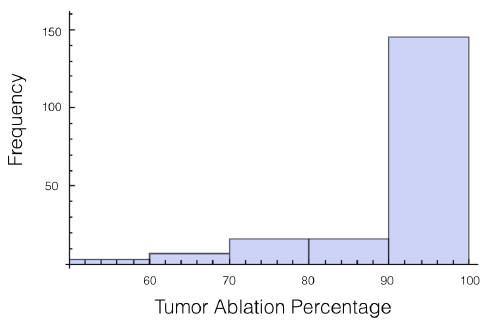
Figure 3. Histogram for percentage of tumor above 700 V/cm for case 1 at 1725 V.